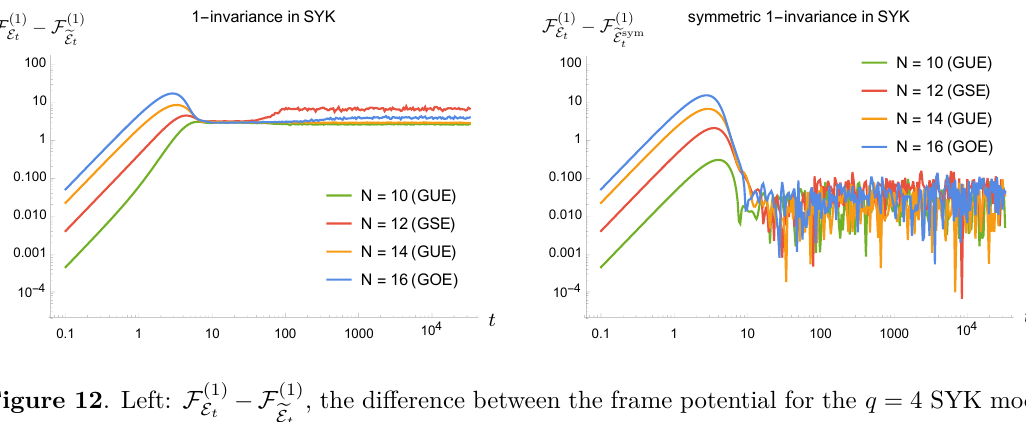
Figure 12 . Left: F (1) − F (1) , the difference between the frame potential for the q = 4 SYK model E t e E t and its unitary-invariant ensemble at different number of Majoranas. Right: the difference between frame potentials where e E sym is taken to be the invariant ensemble with respect to appropriate t symmetry classes for the given N and q